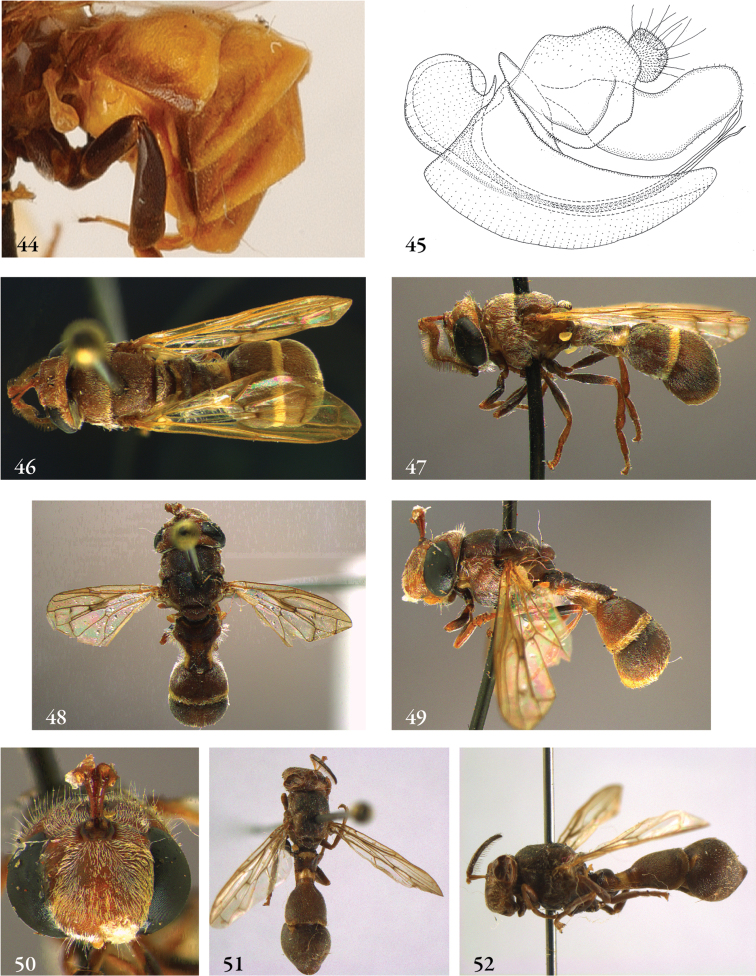
44–45
Ceratophya: 44
Ceratophya panamensis female (paratype), abdomen lateral 45
Ceratophya notata male (holotype), genitalia 46–52
Ceratrichomyia males (holotypes): 46
Ceratophya behara, habitus dorsal 47
Ceratophya behara, habitus lateral 48
Ceratophya bullabucca, habitus dorsal 49
Ceratophya bullabucca, habitus lateral 50
Ceratophya bullabucca, head frontal 51
Ceratophya angolensis, habitus dorsal 52
Ceratophya angolensis, habitus lateral.